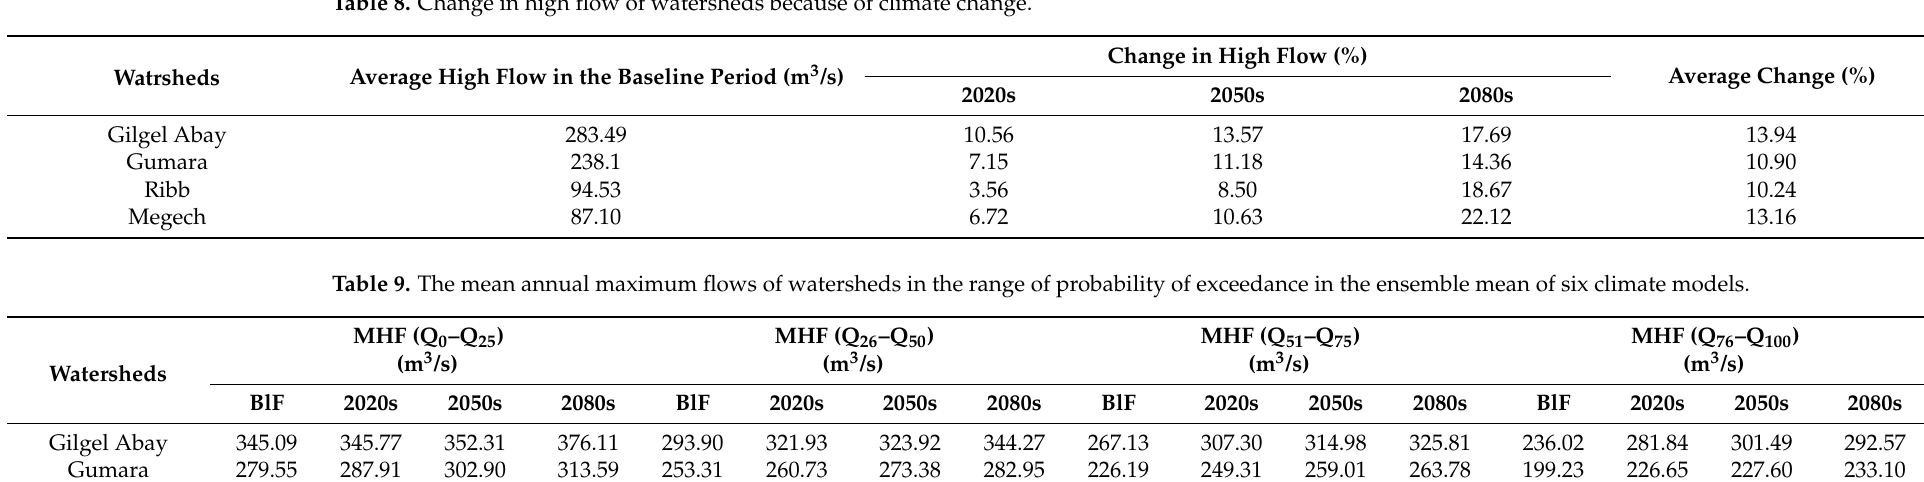
Table 8. Change in high flow of watersheds because of climate change.